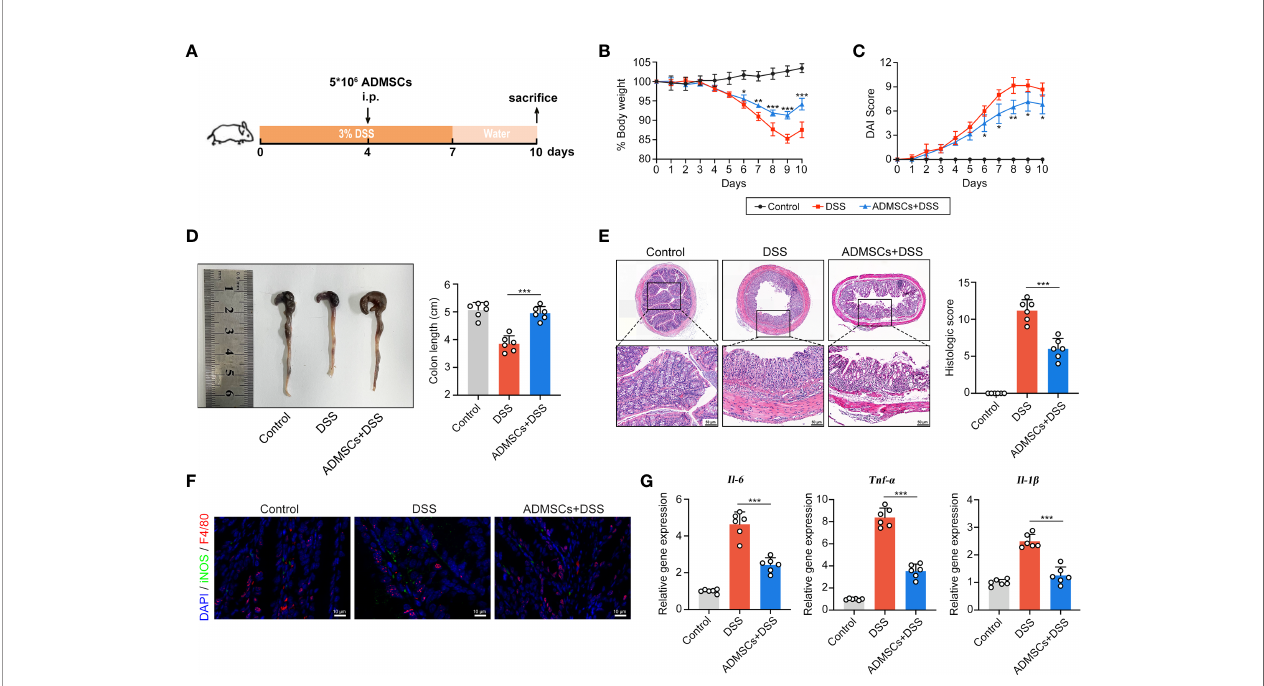
FIGURE 2 | ADMSCs ameliorated DSS-induced colitis and inhibited M1 macrophages in fi ltration. (A) Schematic diagram of animal experiments. Mice in the DSS and ADMSCs+DSS groups were provided with 3% DSS in drinking water to develop colitis. 5×10 6 ADMSCs were intraperitoneally injected to mice in MSC+DSS group on day 4. (B – D) Representative pictures and quanti fi cations of bodyweight (B) , DAI scores (C) and colon lengths (D) from different groups. (E) H&E staining and histological scores of colon tissues from mice with different treatment. (F) Representative images of M1 macrophages in fi ltration in colon tissues assessed by Immuno fl uorescence staining. (green for F4/80, red for iNOS and blue for DAPI). (G) Gene expression of IL-6, TNF- a and IL-1 b assessed by qRT-PCR. (*p < 0.05; **p < 0.01; ***p < 0.001).